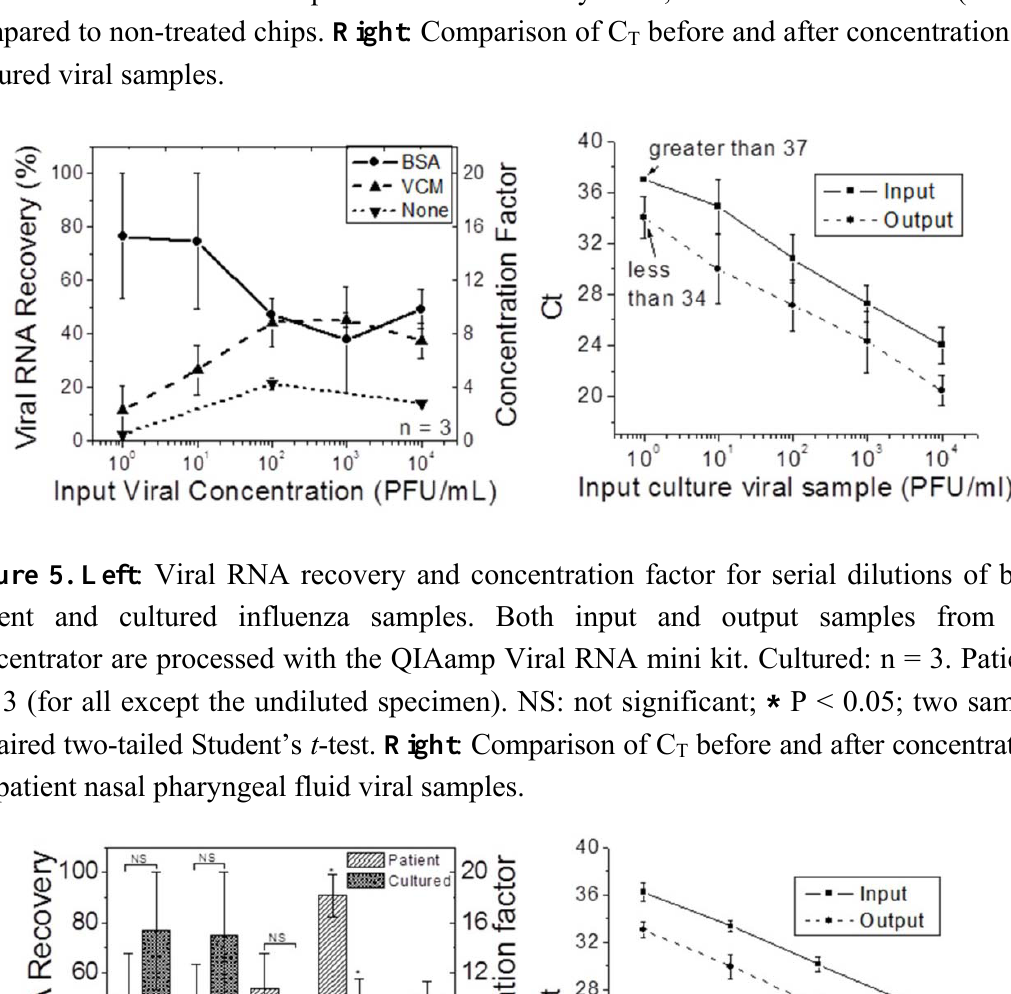
before and after concentration for T